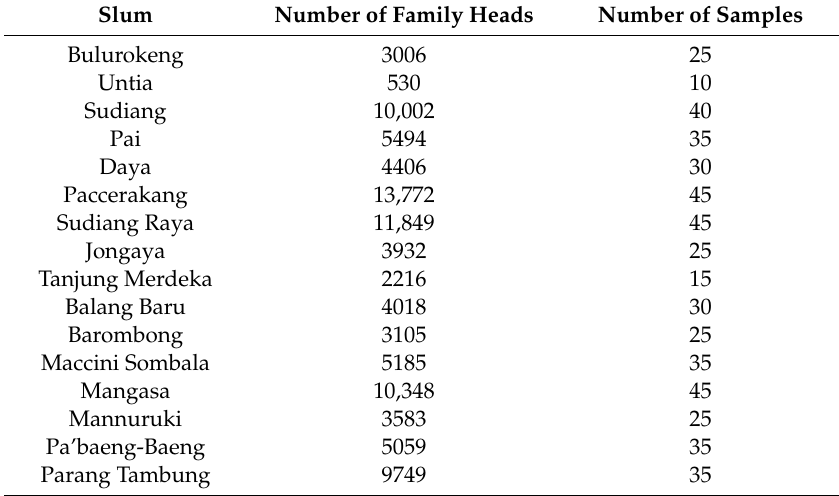
Table 4. Number of respondents in the study area Biringkanaya and Tamalate Districts, Makassar. Slum Number of Family Heads Number of